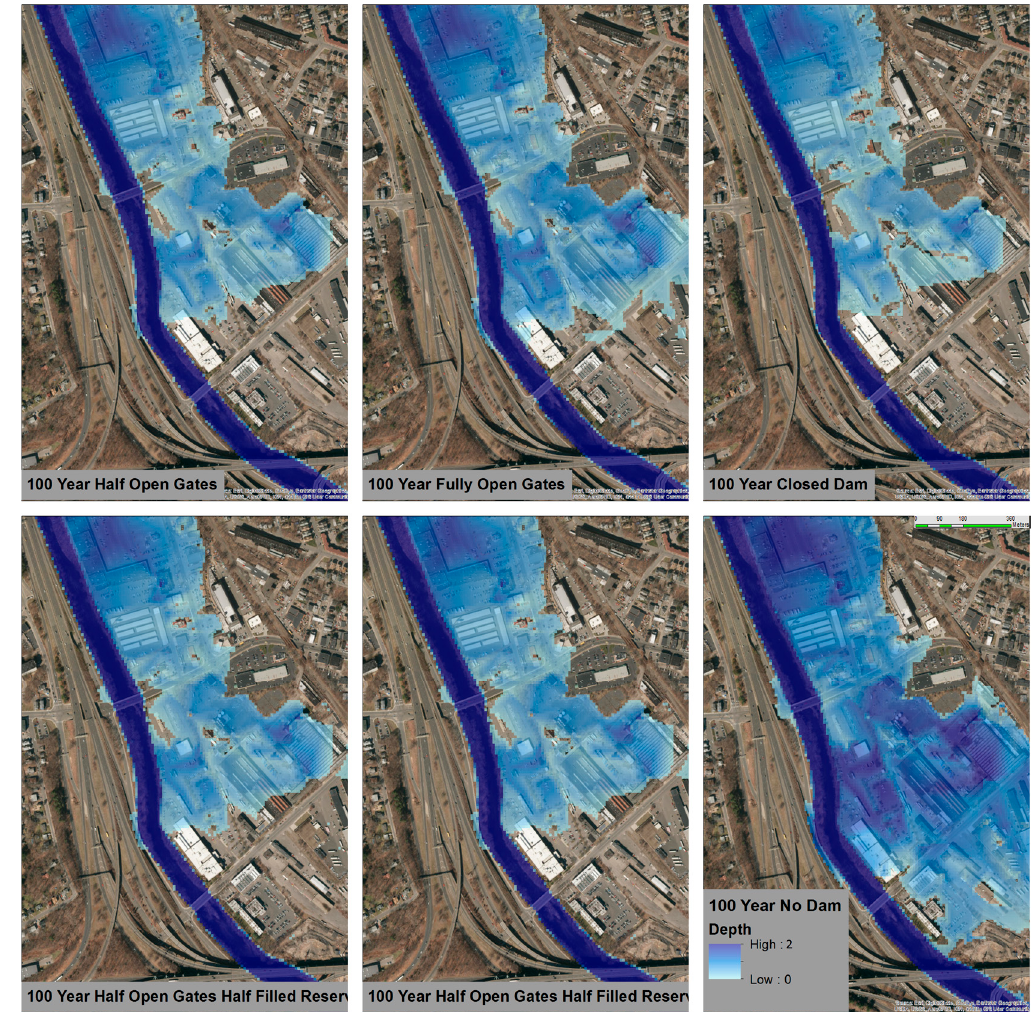
Figure 9. Simulated maximum 100-year flood inundation in various dam operation scenarios.